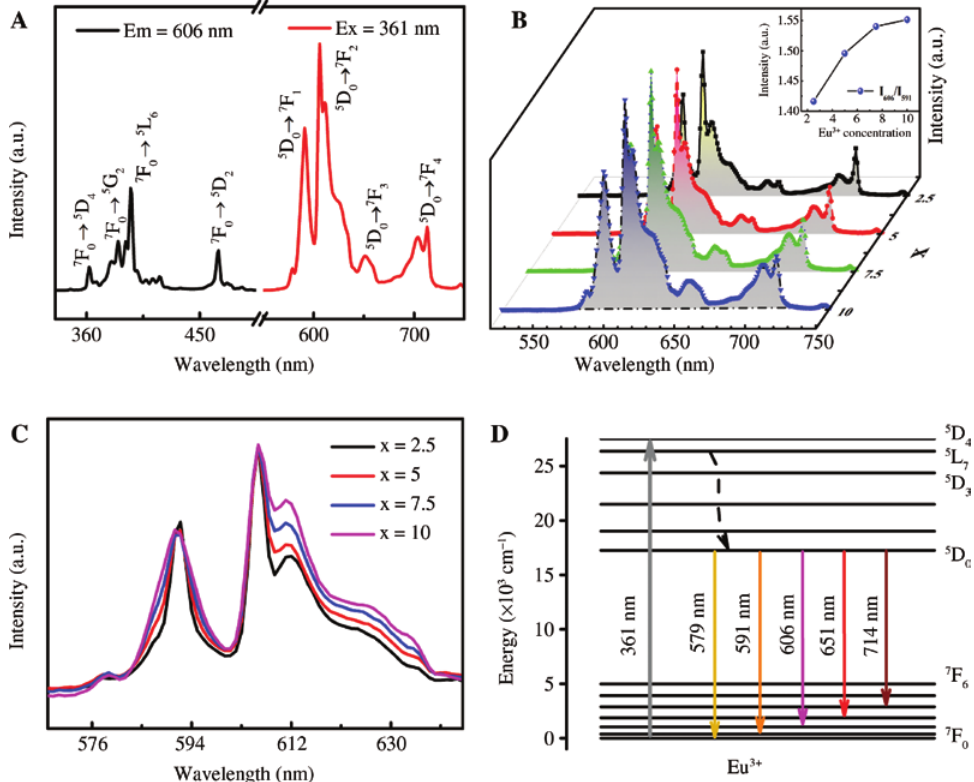
Figure 5: Photoluminescence behaviors and the corresponding mechanism. (A) Excitation (black curve) and emission spectrum (red curve) of ZrO :10%Eu 3 + . (B) Emission spectra of the tetragonal ZrO 2 nanocrystals under 361 nm excitation. (C) Emission spectra normalized to the peak at 606 nm. (D) Schematic energy level diagram as well as the PL mechanism of Eu 3 + in ZrO 2